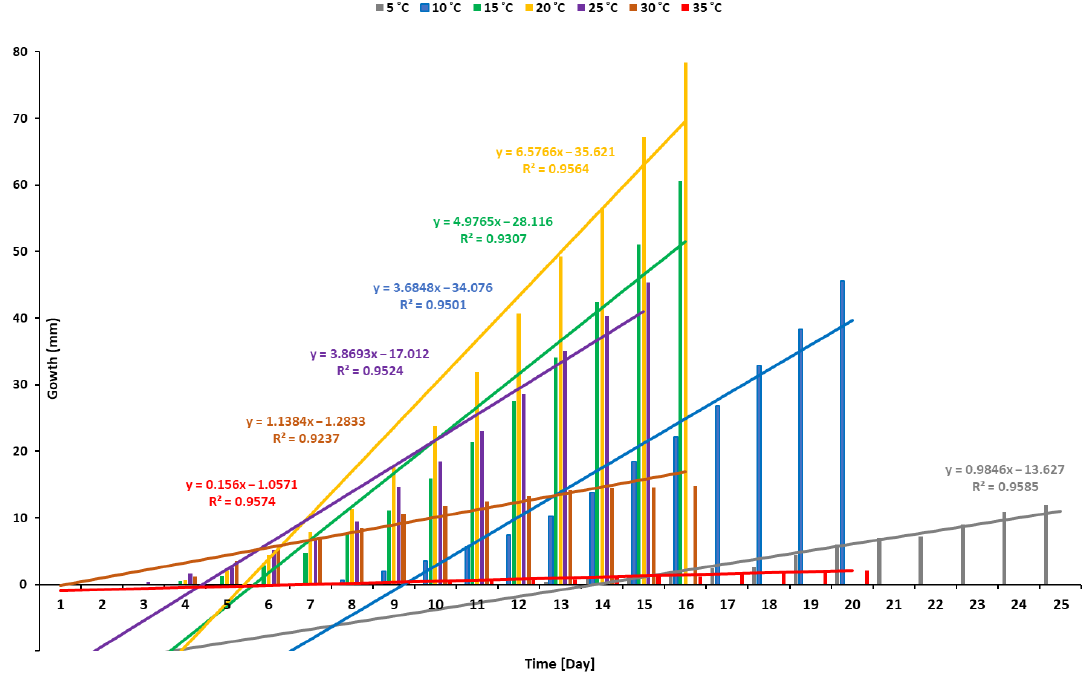
Figure 1. Recorded data on the germination time of rapeseed crop at different levels of tempera- ture.